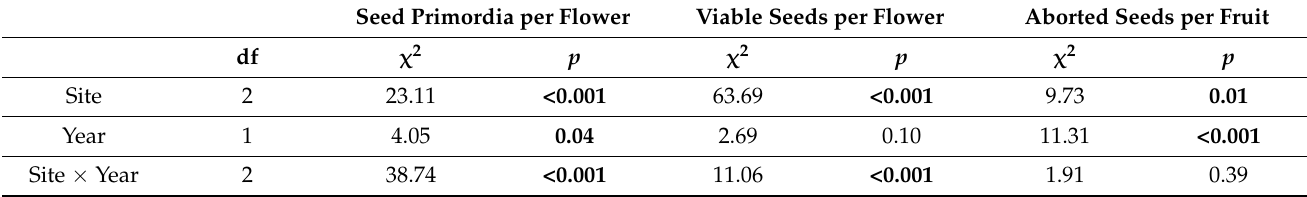
Table 1. Generalized linear models testing the effects of site, year, and their interaction on the number of seed primordia per flower, number of viable seeds per fruit, and number of aborted seeds per fruit. Results with p < 0.05 in